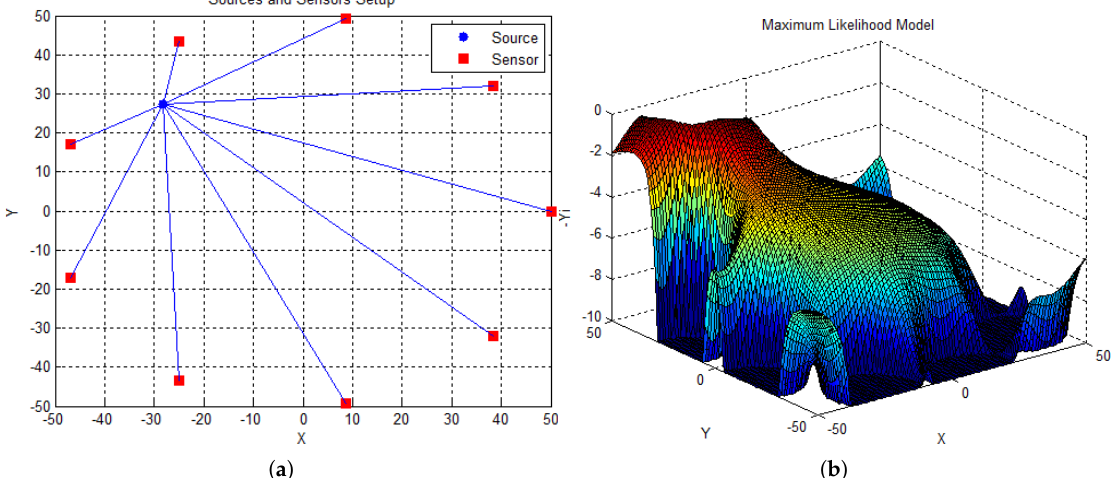
Figure 1. Graphic Representation of ML Model. ( a ) Sensors and Source Setup. ( b ) Surface